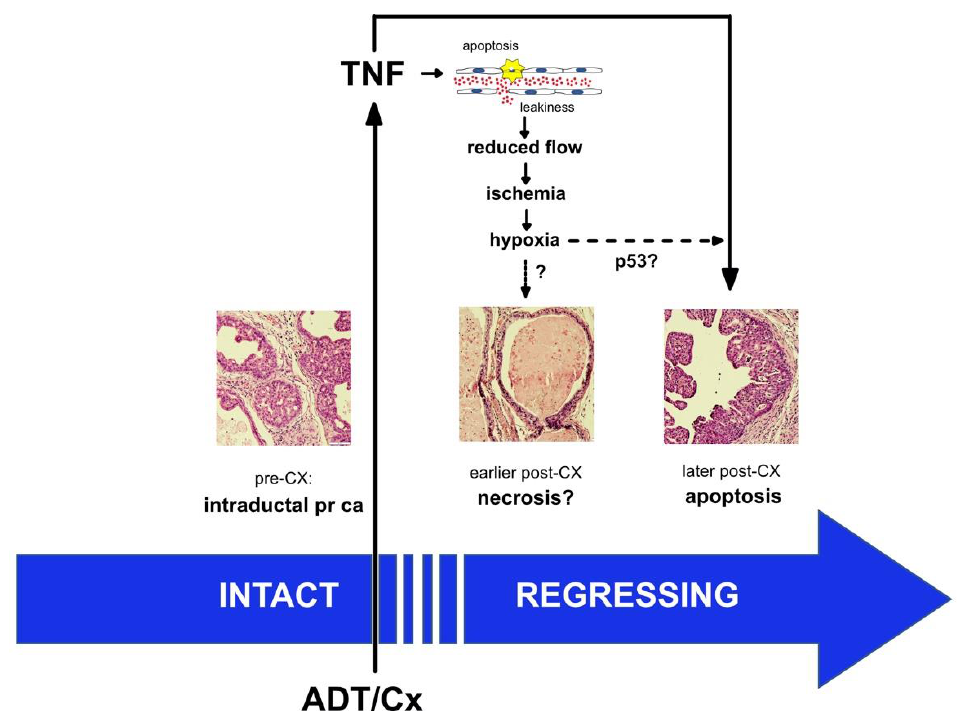
Figure 7. Proposed mechanism for TNF regulation of prostate regression. A proposed mechanism for prostate cancer regression following androgen deprivation therapy is illustrated, focusing on the contribution of events that are mediated by the tumor microvasculature. We propose that one of the earliest events is the activation of TNF signaling in endothelial cells, leading to increased permeability ( ‘ leakiness ’ ) and endothelial cell death. The damage to the endothelium leads to a cascade of vascular changes — reduced blood flow, ischemia due to reduced perfusion, and eventually transient tissue hypoxia — that likely enhances the death of the epithelial component of the tumor. A prediction of the model is that endothelial cell apoptosis precedes epithelial cell apoptosis, which has been noted in the literature (see text). There is limited support for the usual cell death consequence of hypoxia (namely necrosis or necroptosis), but there is a partial requirement for p53 in castration-induced regression, suggesting that p53-hypoxia signaling contributes to death receptor-mediated apoptosis of epithelial tumor cells.